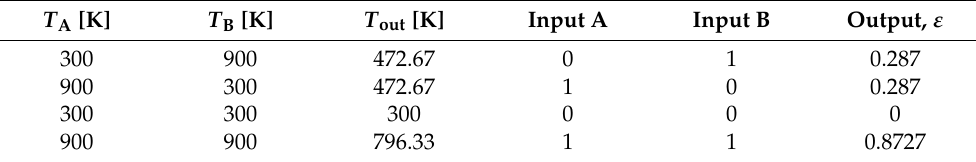
Table 1. AND gate based on thermal rectifier and resulting truth table. The temperature is fixed at a high temperature of 900 K (high input, 1) or a low temperature of 300 K (low input, 0). The output, ε , is calculated, demonstrating that a high output only occurs when both of the inputs are high. Other logic gates can be created using a similar strategy to that employed here.